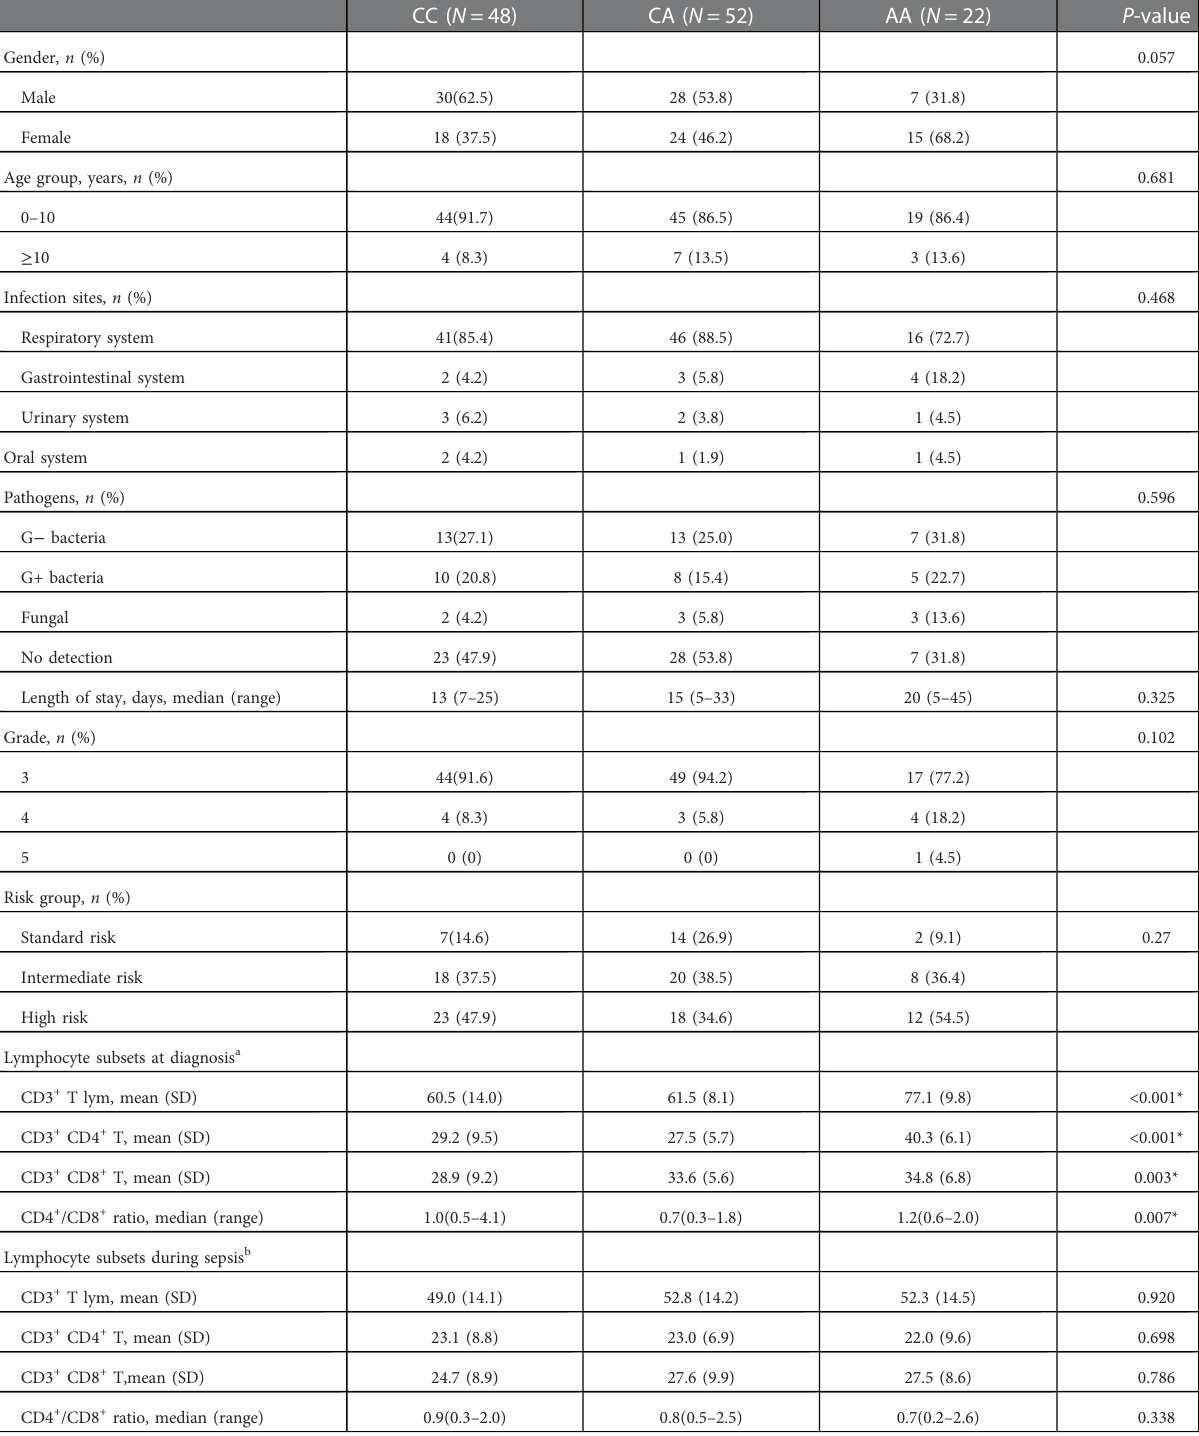
TABLE 4 The characteristics of sepsis among GATA3 rs3824662 genotypes in pediatric